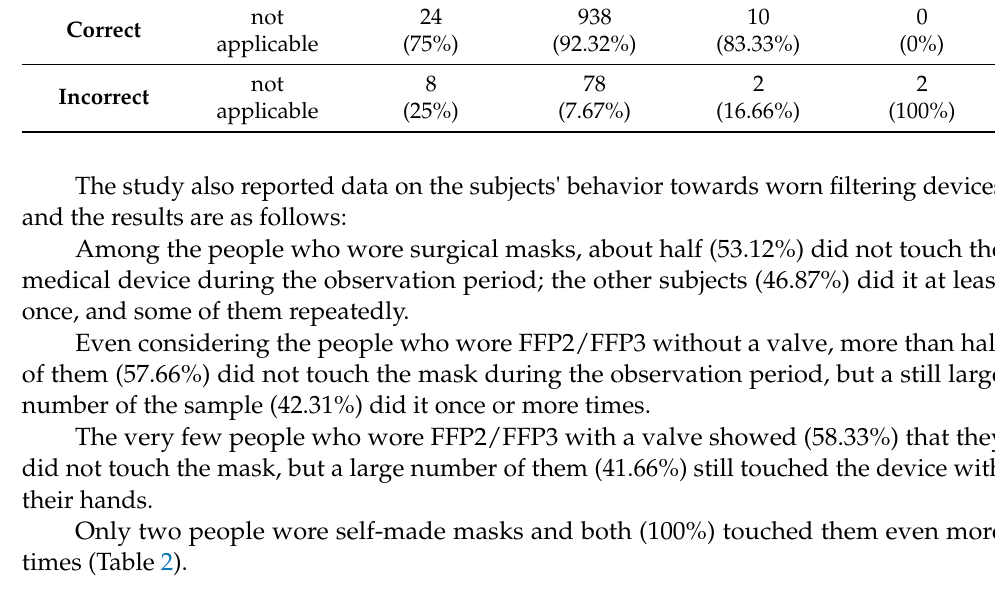
Table 2. Distribution of result about